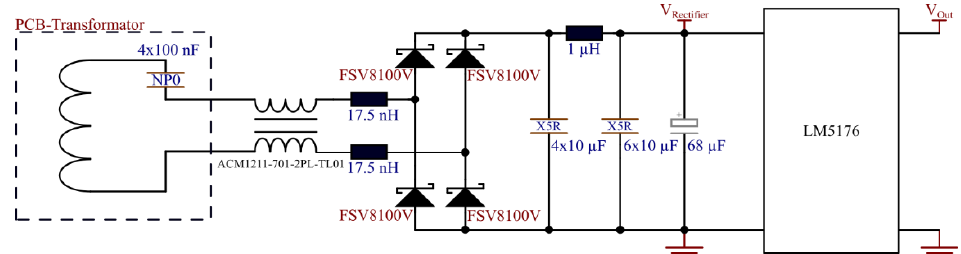
Figure 4. Circuit diagram of the voltage rectification and regulation on the secondary side of the isolated DC power supply.